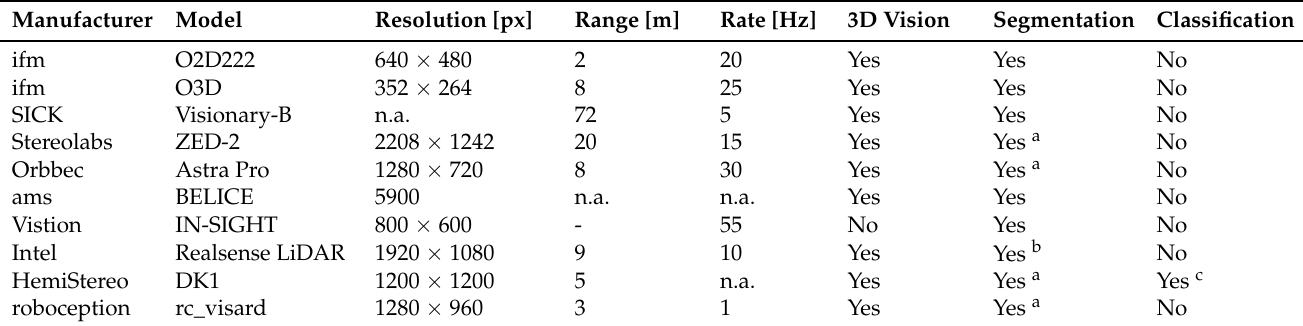
Table 1. Comparison of industrial item detection applications; range and rate refer to maximum